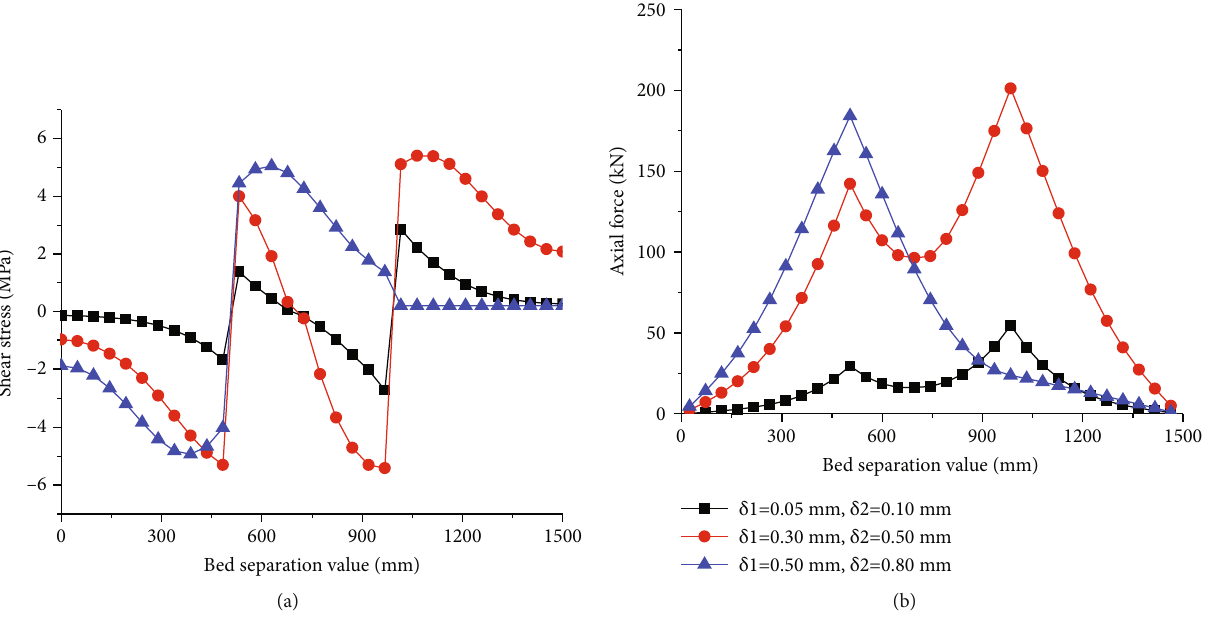
Figure 12: (a) The interfacial shear stress and (b) axial force distribution curves versus di ff erent bedding separation values with double bedding